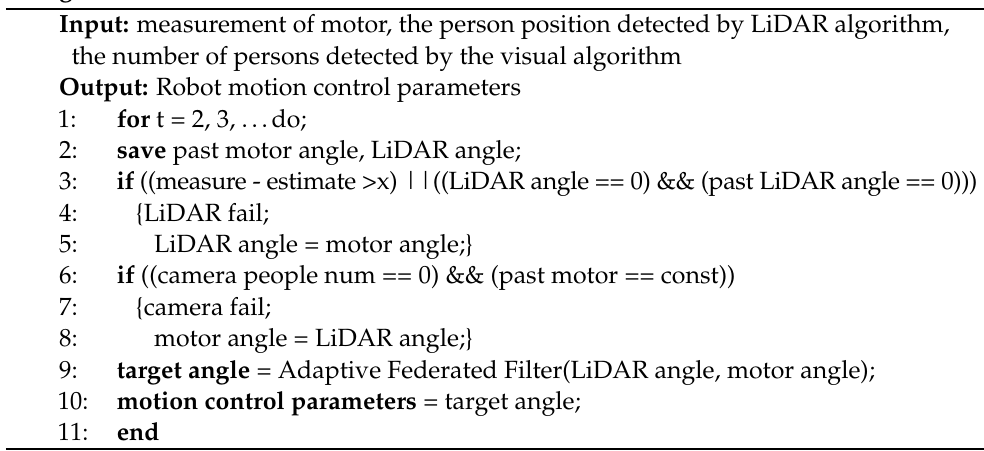
Algorithm 1: Fault detection and